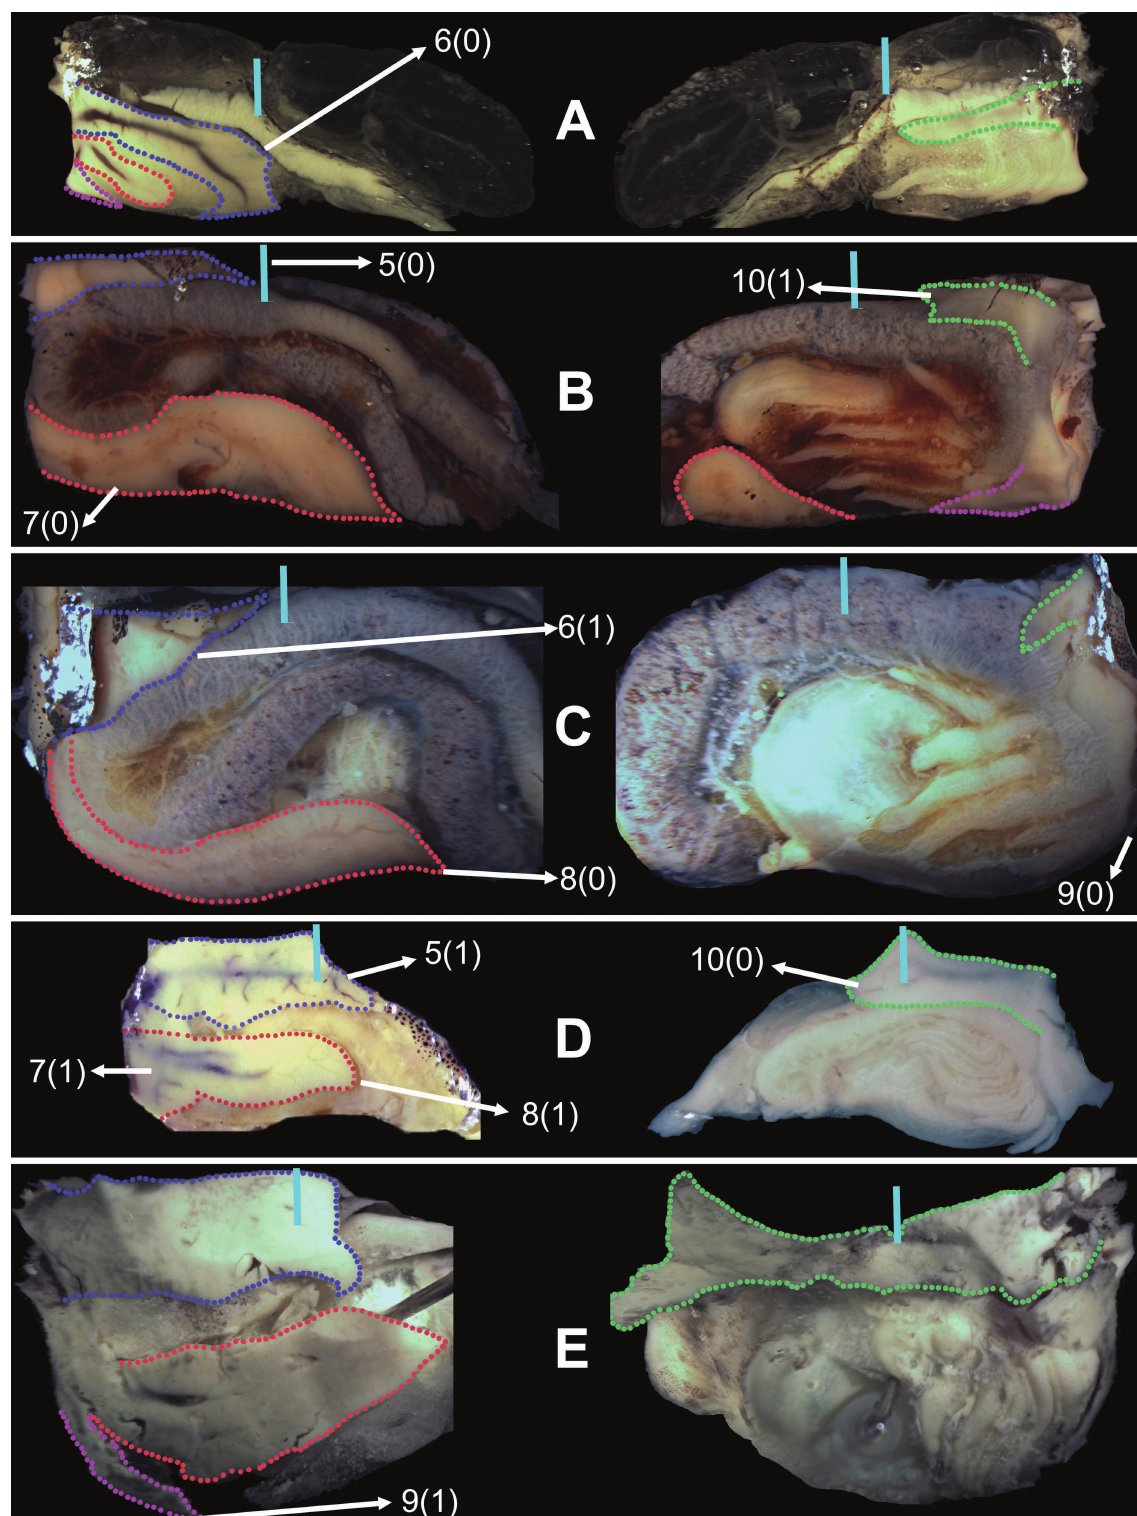
Fig. 3. Liver lobes of selected species of Characidae family. Lateral view. Anterior to left at the left side of the figure. Anterior to right at the right side of the figure. Proposed primary homologue lobes are delimited by the same color. Light blue bar indicates approximately position of anterior distal margin of gas bladder posterior chamber. Characters are indicated with numbers and character states between parentheses. A - Aphyocharax anisitsi ; B - Cheirodon interruptus ; C - Bryconamericus thomasi ; D - Astyanax rutilus ; E - Markiana nigripinnis .